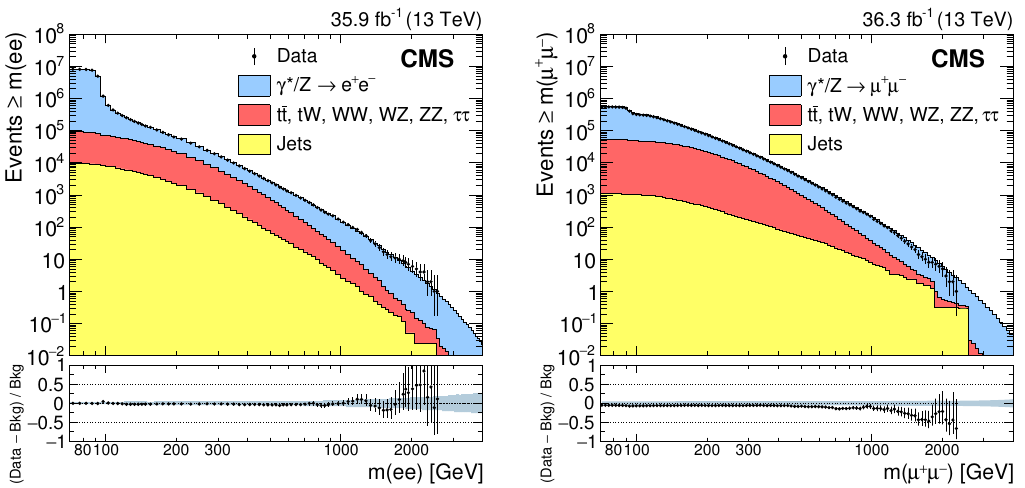
Figure 2 . The cumulative distributions, where all events above the speci(cid:12)ed mass on the x axis are summed, of the invariant mass spectra of dielectron (left) and dimuon (right) events. The points with error bars represent the observed yield. The histograms represent the expectations from SM processes. The uncertainty bands in the ratio plots represent the systematic uncertainty in the background yields.